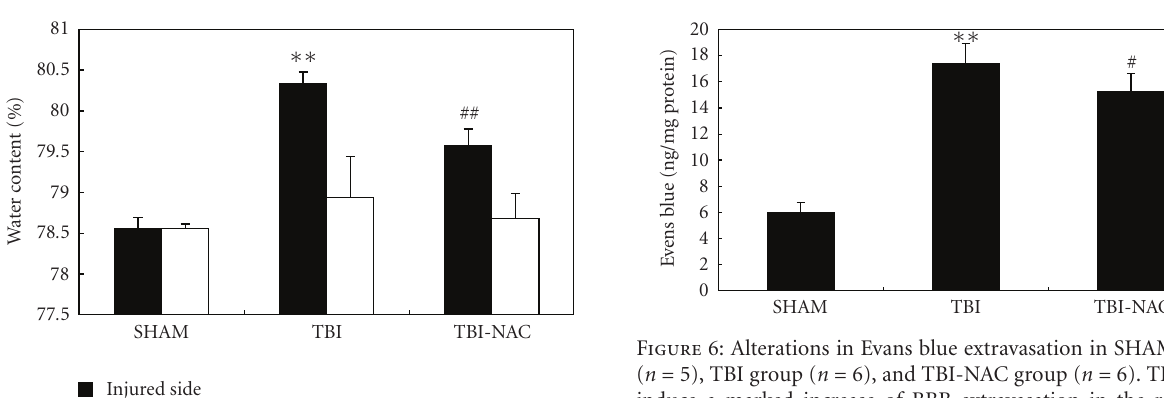
Figure 6: Alterations in Evans blue extravasation in SHAM group ( n = 5), TBI group ( n = 6), and TBI-NAC group ( n = 6). TBI could induce a marked increase of BBB extravasation in the rat brain compared with SHAM group. After NAC administration, the Evans blue extravasation was significantly reduced as compared with TBI group. ∗∗ P < . 01 versus SHAM group, # P < . 05 versus TBI